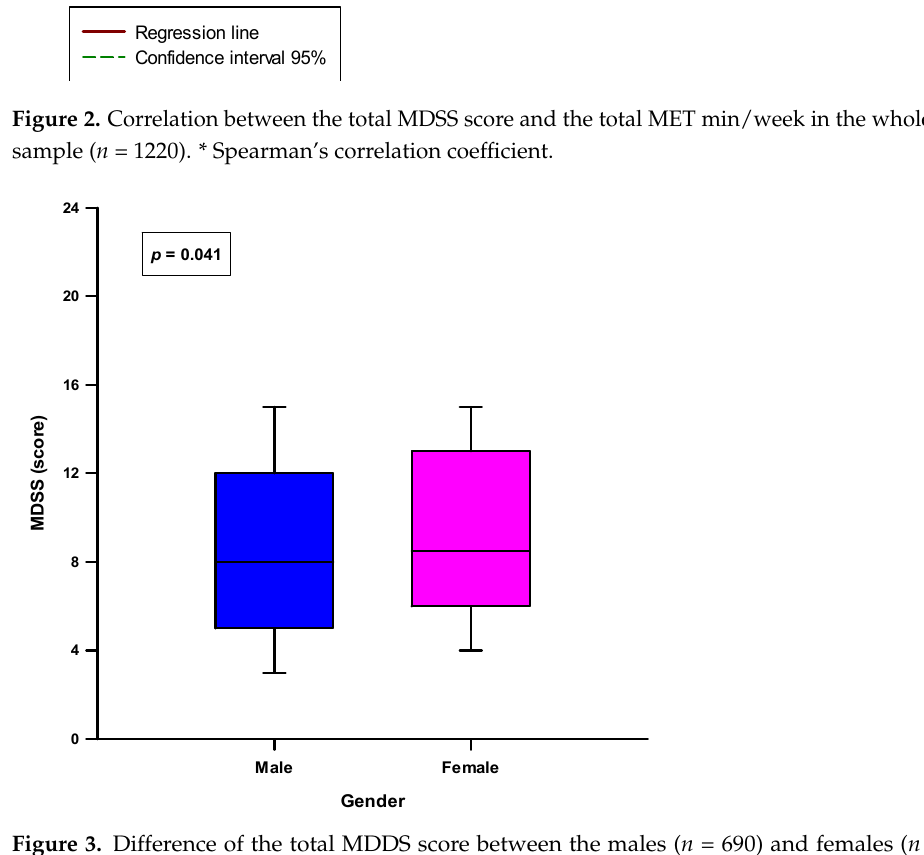
Figure 3. Difference of the total MDDS score between the males ( n = 690) and females ( n = 530). Tested with the Mann-Whitney U test.